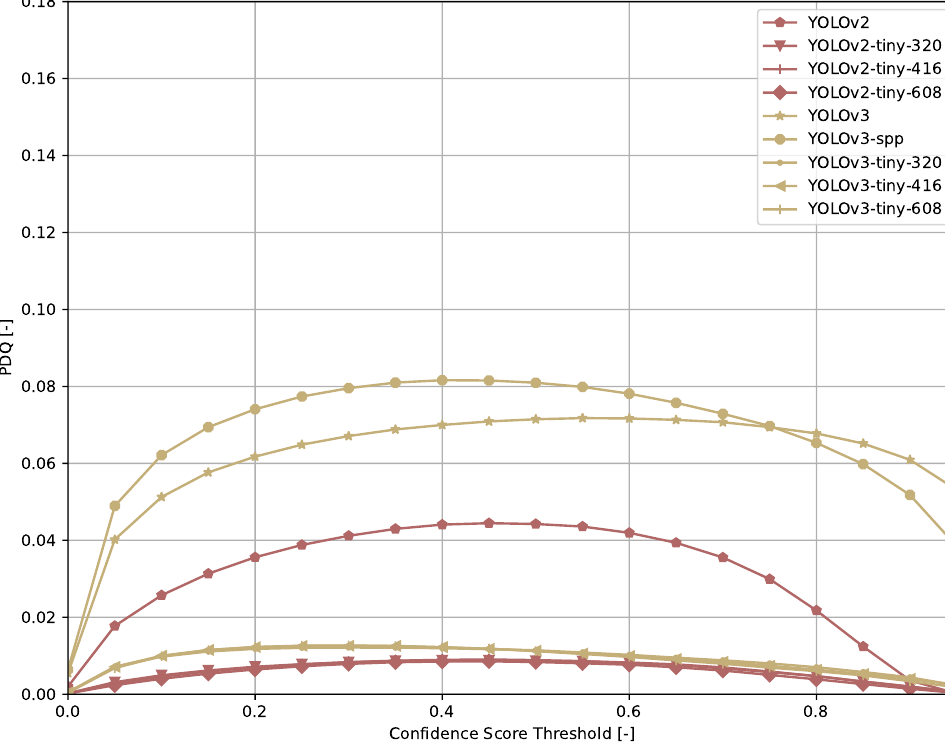
Figure 13. PDQ results of YOLOv{2,3} on the COCO